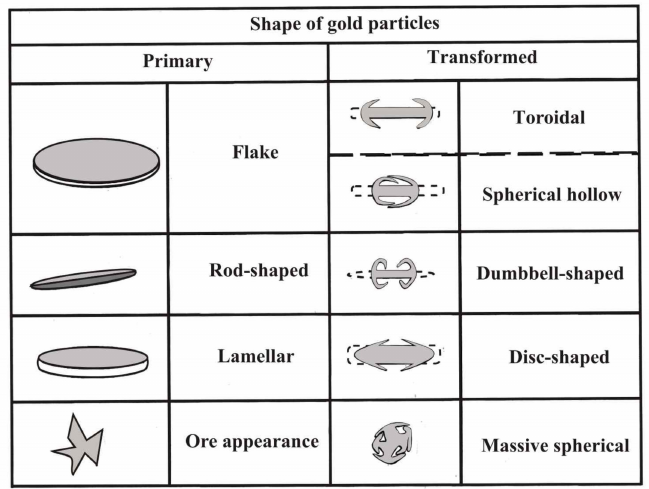
Figure 4. Transformation of gold particles of various shapes in an air–sand flow.